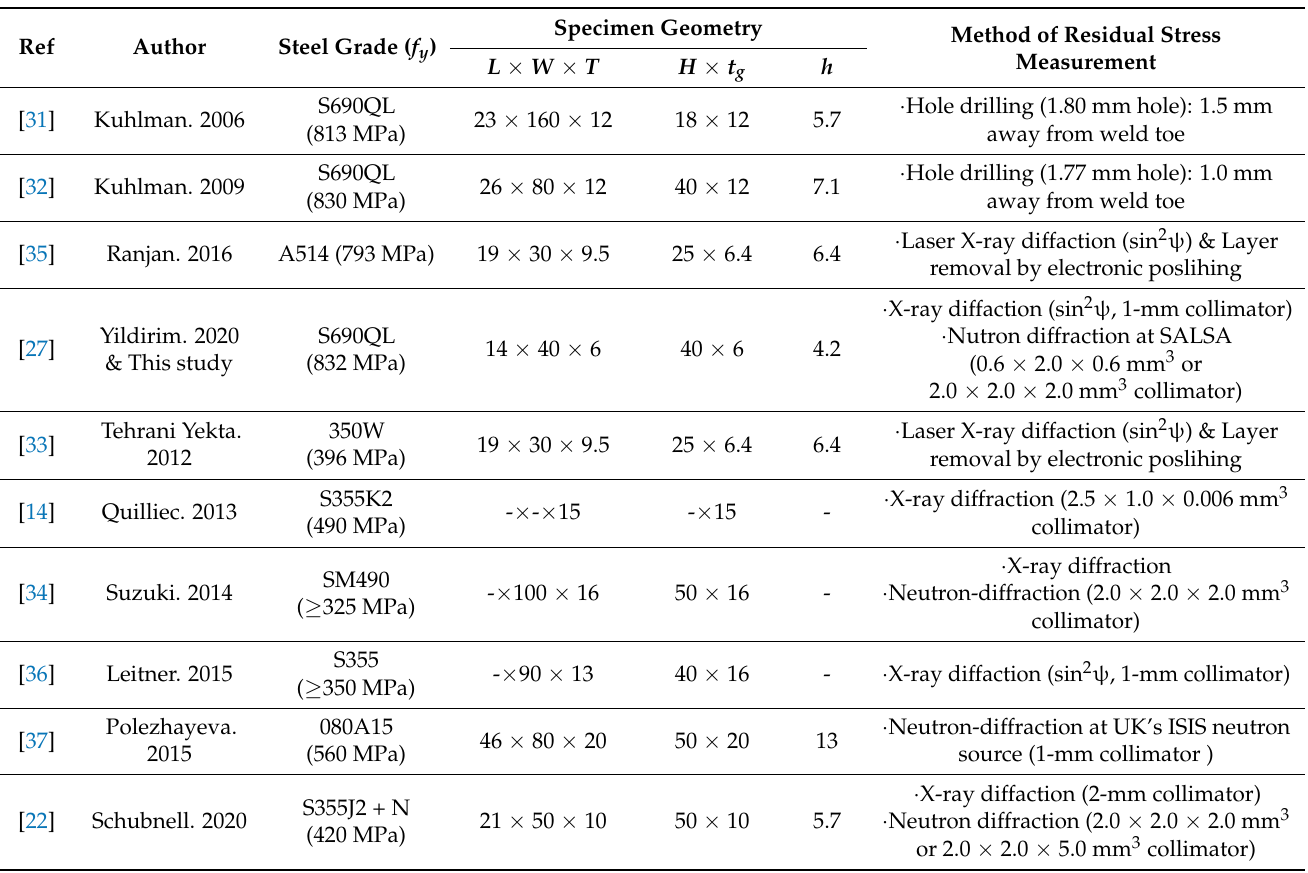
Table A1. Detailed information of literature on specimen geometry and residual stress measure- ment